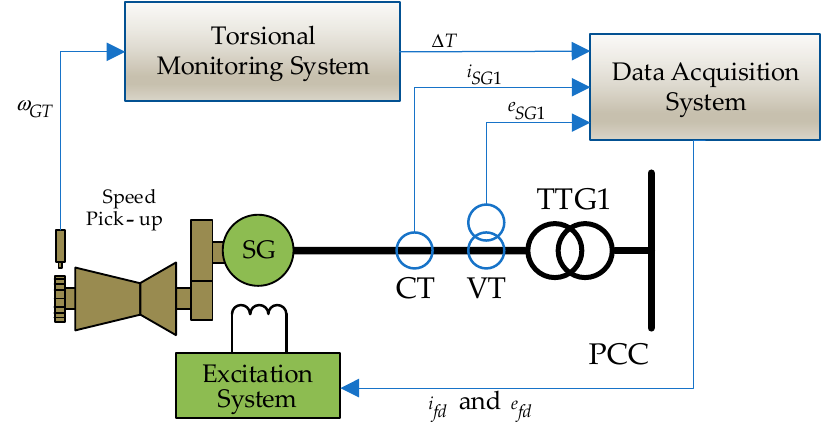
Figure 8. Experimental set-up: TG unit.